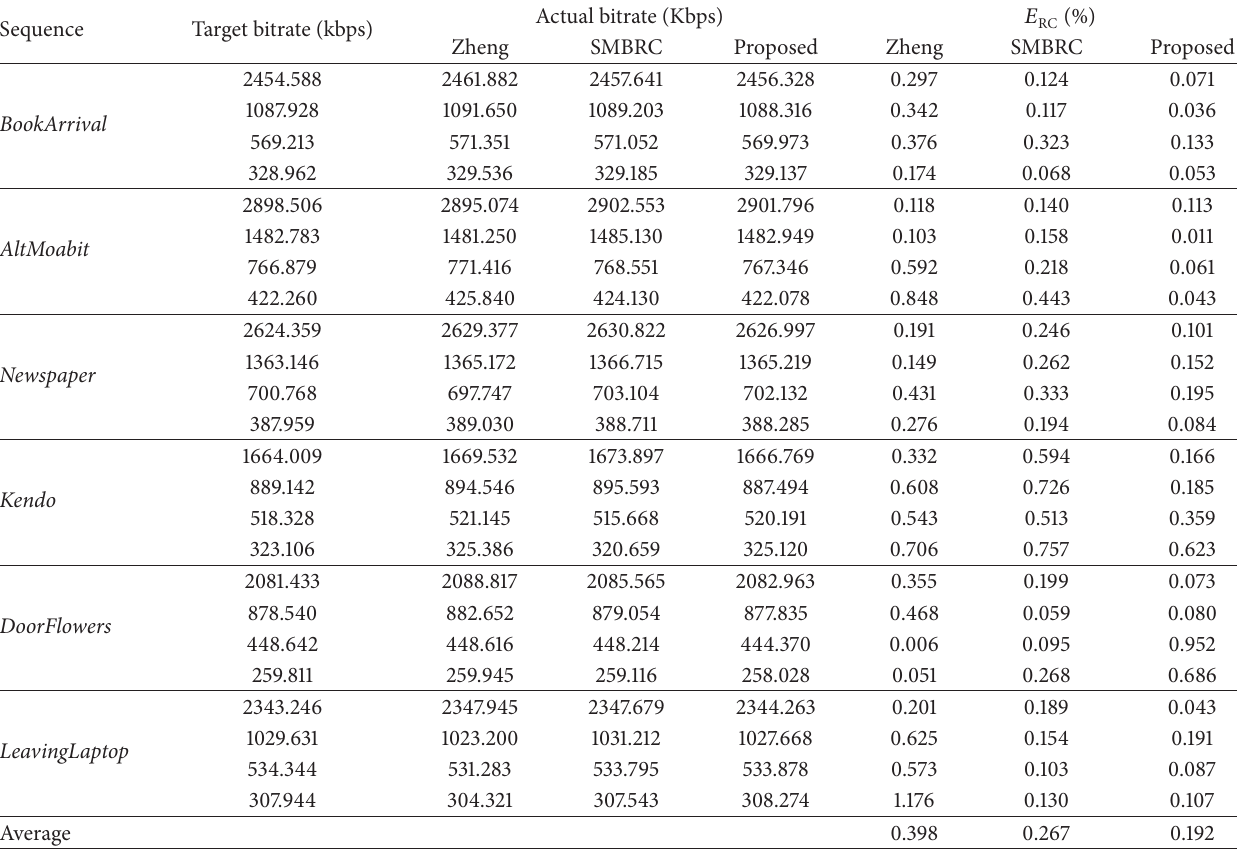
Table 2: The detailed control accuracies of the three schemes.